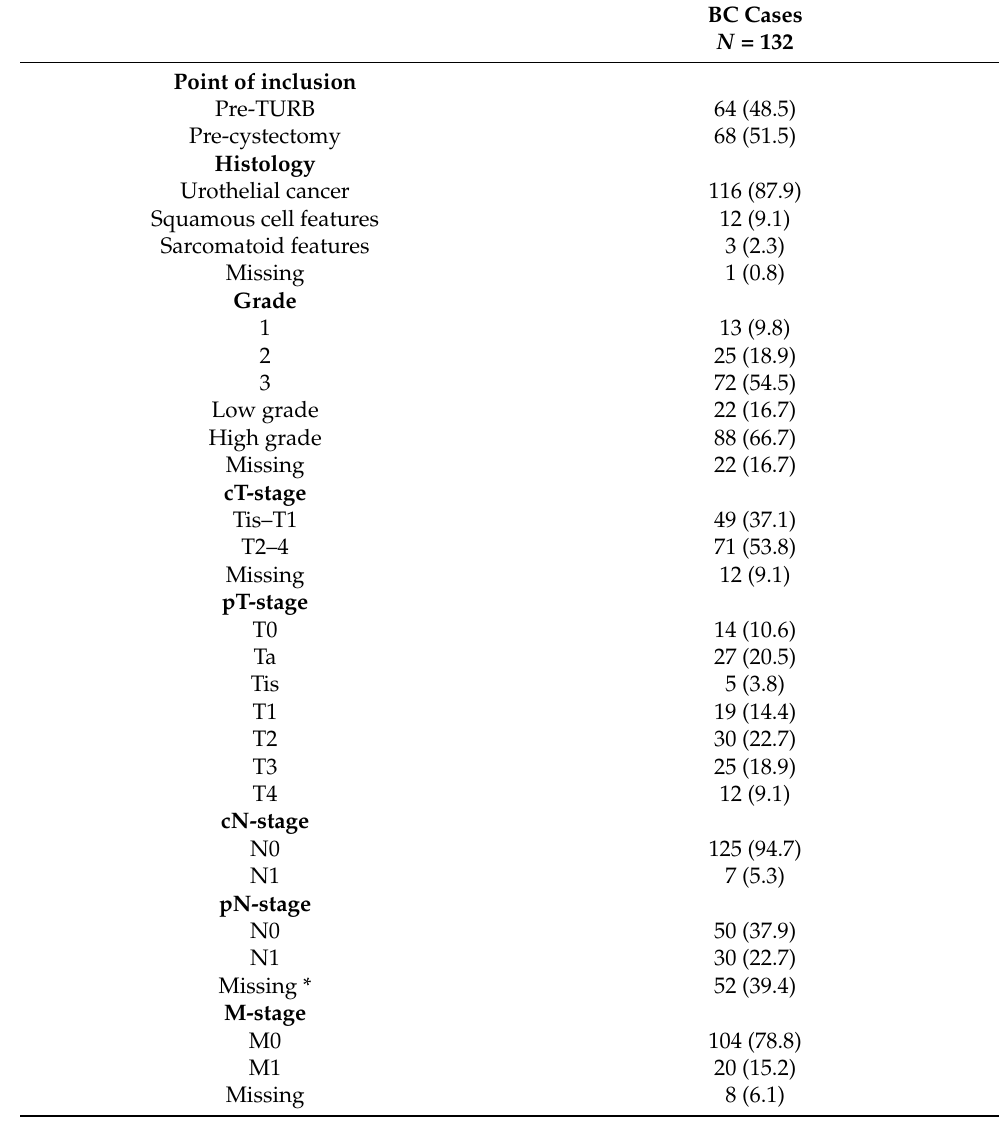
Table 2. Tumor characteristics of patients with urothelial bladder cancer